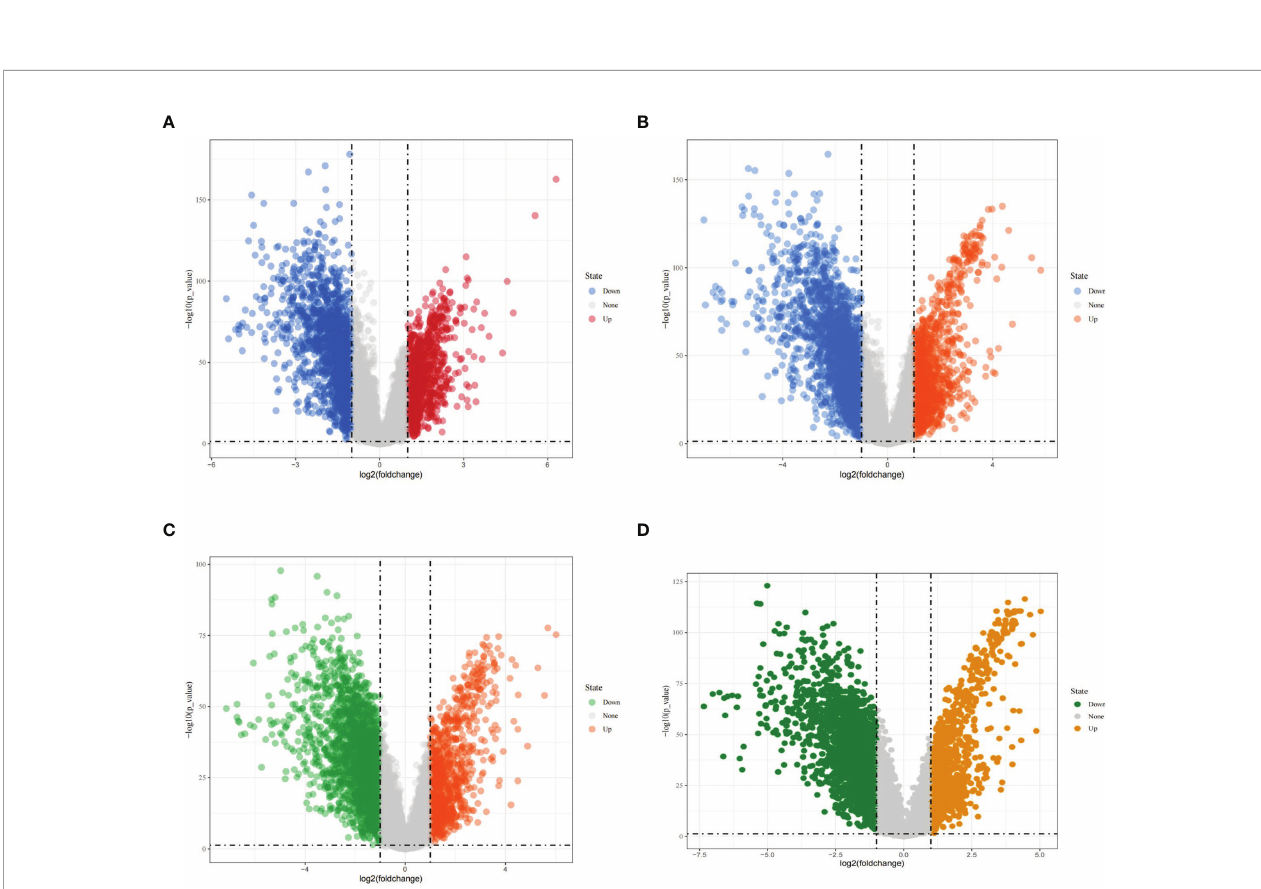
FIGURE 2 | Differentially expressed genes in different types of breast cancer. (A) Volcano diagram showing differentially expressed genes in luminal A breast cancer; (B) Volcano diagram showing differentially expressed genes in luminal B breast cancer; (C) Volcano diagram showing differentially expressed genes in HER2-enriched breast cancer; (D) Volcano diagram showing differentially expressed genes in basal-like breast